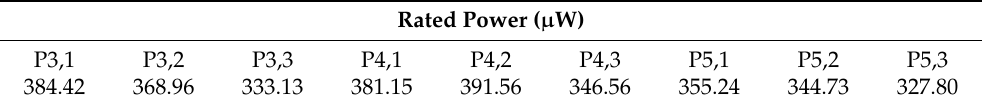
Figure 6. Schematic of the LED power measurement matrix in the sample area. Table 1. Table of rated power in the sample room.